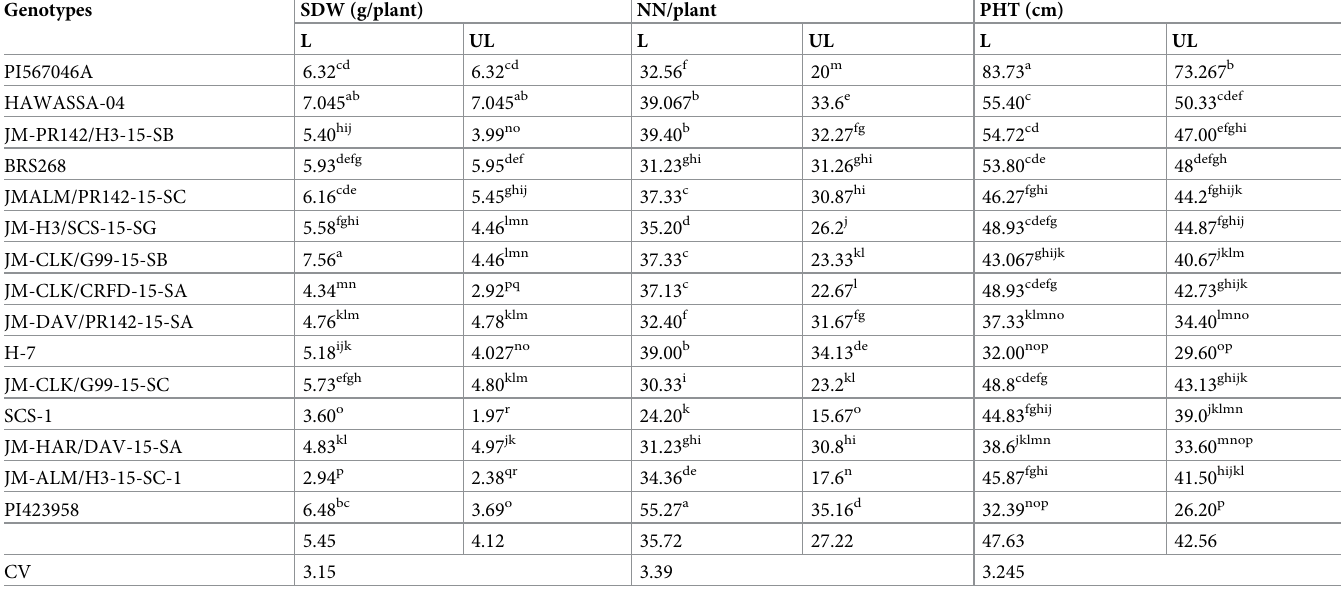
Table 7. Interaction effect of genotypes and lime for SDW, NN and PHT of soybean genotypes grown under limed and unlimed soil at Mettu during 2017 main cropping